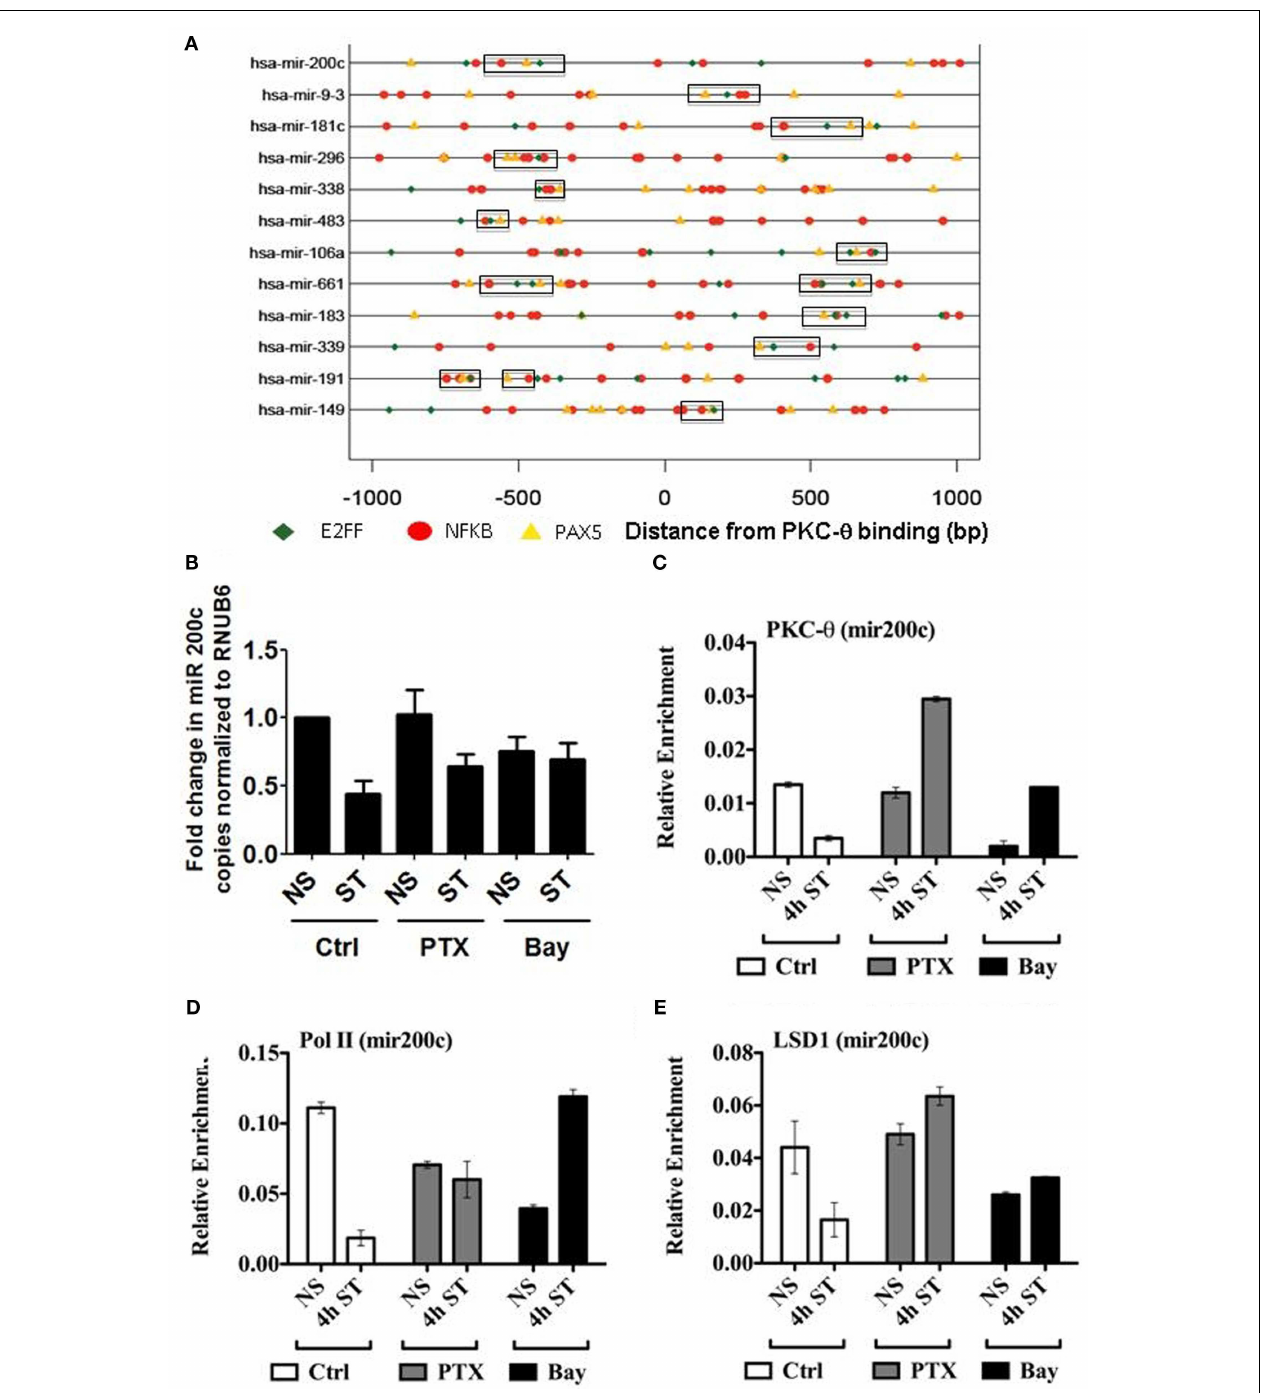
Pentoxifylline (PTX) or Bay. Data expressed as fold change in miR-200c relative to NS set to 1 and normalized to RNU6B. Data representative of the mean ± SE of three independent experiments. (C) PKC- θ , (D) Pol II, and (E) LSD1 ChIP were carried out on samples as described for (B) . Sybr-green real-time PCR was used to detect the relative enrichment of these proteins across the miR-200c promoter. ChIP data are expressed as relative enrichment and plotted as the mean ± SE of two independent experiments performed in